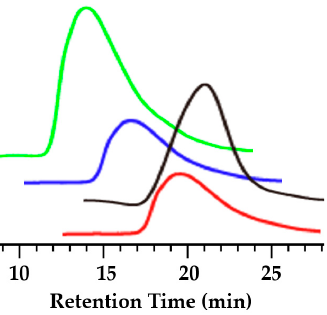
Figure 2. GPC curves of synthesized polymers: black, NH 2 -PS-NH 2 ; green, PAA I - b -PS; blue, PAA II - b -PS; red, PAA III - b -PS.